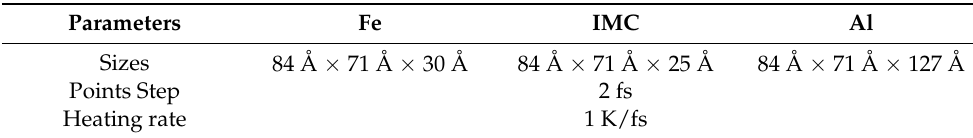
Figure 2. Al, Fe atoms IMC conformation. Table 2. Atomic configuration parameters.